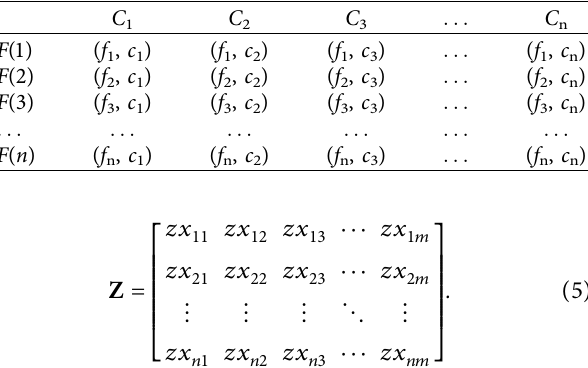
Table 1: The incidence matrix of data node